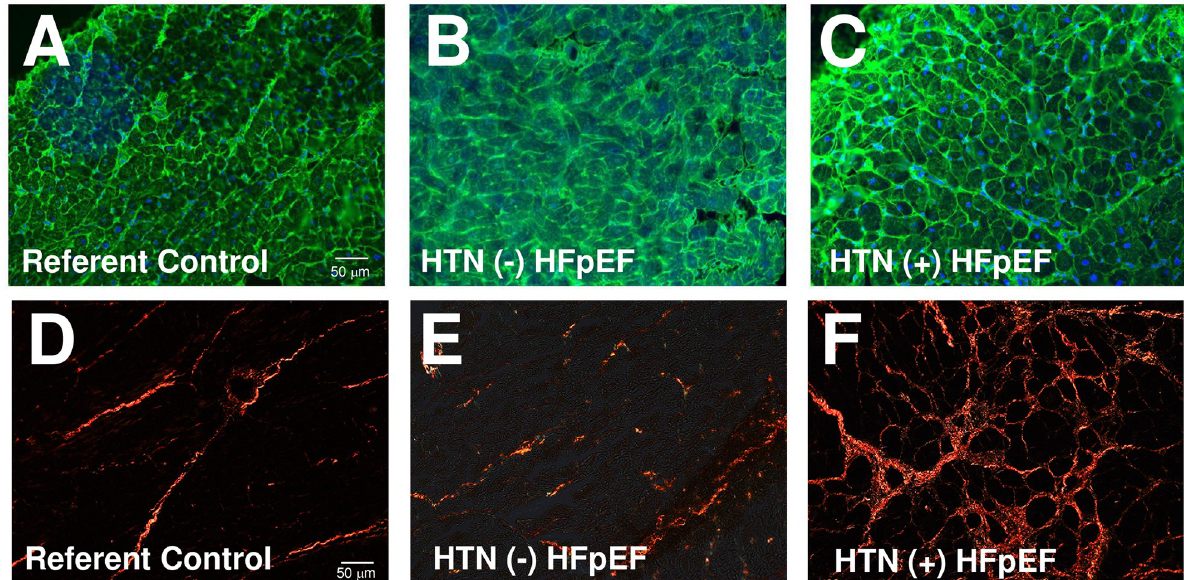
Fig 1. Representative sections from epicardial biopsies stained with wheat germ agglutin (WGA) were used to assess cardiomyocyte cross-sectional area (CSA) from patients categorized as A) Referent control, B) HTN (-) HFpEF, and C) HTN (+) HFpEF. Collagen volume fraction was assessed by picro-sirius red (PSR) stained tissue sections from D) Referent control, E) HTN (-) HFpEF, and F) HTN (+) HFpEF biopsies. Scale bar in A and D are indicative of magnification in each panel.